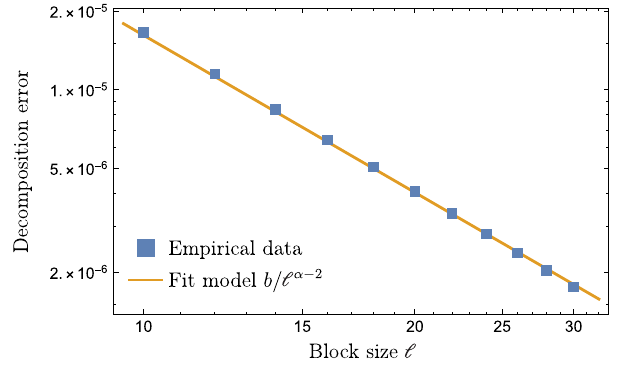
FIG. 8. The empirical error of the unitary decomposition in Lemma 1, computed for the single-excitation one-dimensional Heisenberg chain ( α ¼ 4 ) in Eq. (25) at different values of l . The system size is fixed at n ¼ 300 and the evolution time at t ¼ 0 . 01 . We fit the data (blue square) to the theoretical model b= l α − 2 and obtain b ¼ 1 . 62 × 10 − 3